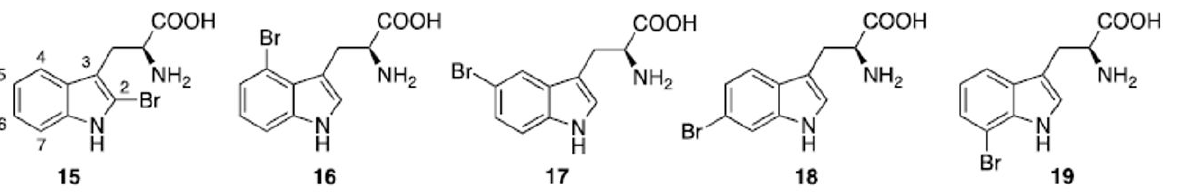
Figure 5. Naturally occurring halogenated